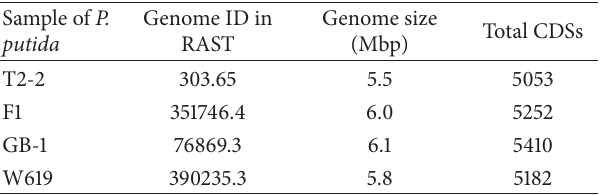
Table 2: Summary of T2-2 draft genome compared with other P. putida complete genomes available in RAST. Sample of